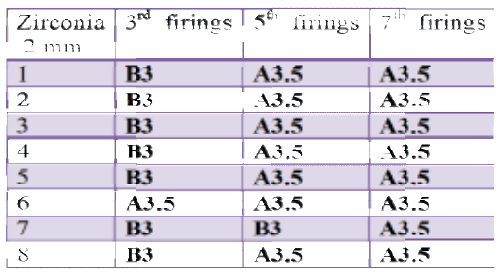
Table 3: Shade results of group A3